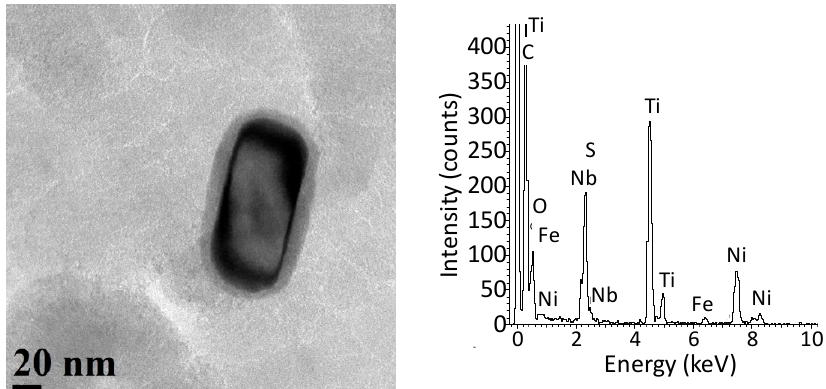
Figure 5. S-, Nb- and Ti- containing precipitate found in the carbon replicas extracted from the Ti10Nb3 specimen quenched for initial microstructure analysis.